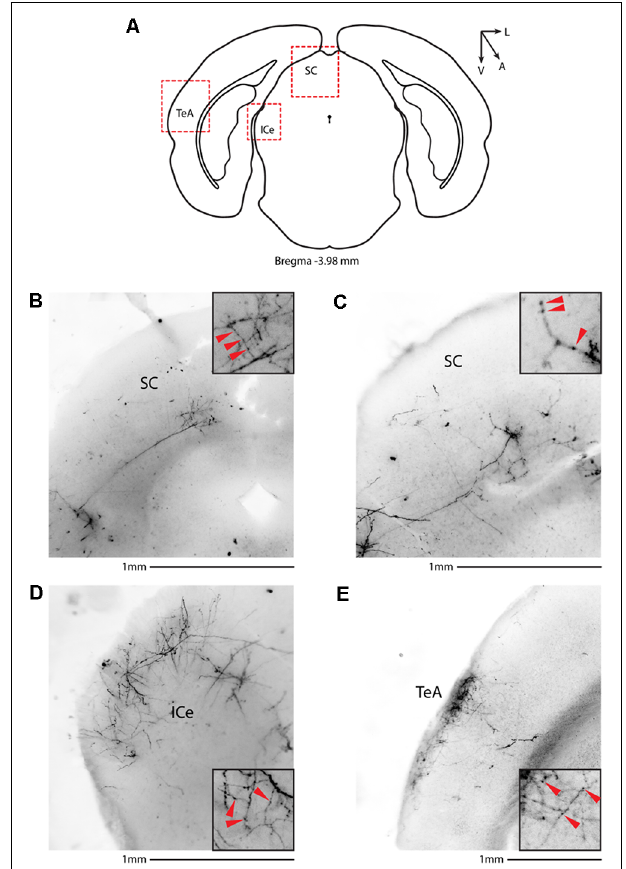
FIGURE 4 | Subcortical target of long-range VIP-expressing neurons: midbrain. (A) Allen Brain reference coronal section at − 3.98 mm from Bregma. Red dashed squares indicate the regions imaged in the panels below. (B,C) Two examples of the superior colliculus, from two animals. (D) Representative image of the external cortex of inferior colliculus. (E) Representative image of the temporal association cortex. Scale bars: 1 mm. Insets indicate axonal branches and the red arrowheads boutons. Inset size 190 µ m. SC, superior colliculus; ICe, inferior colliculus, external; TeA, temporal association